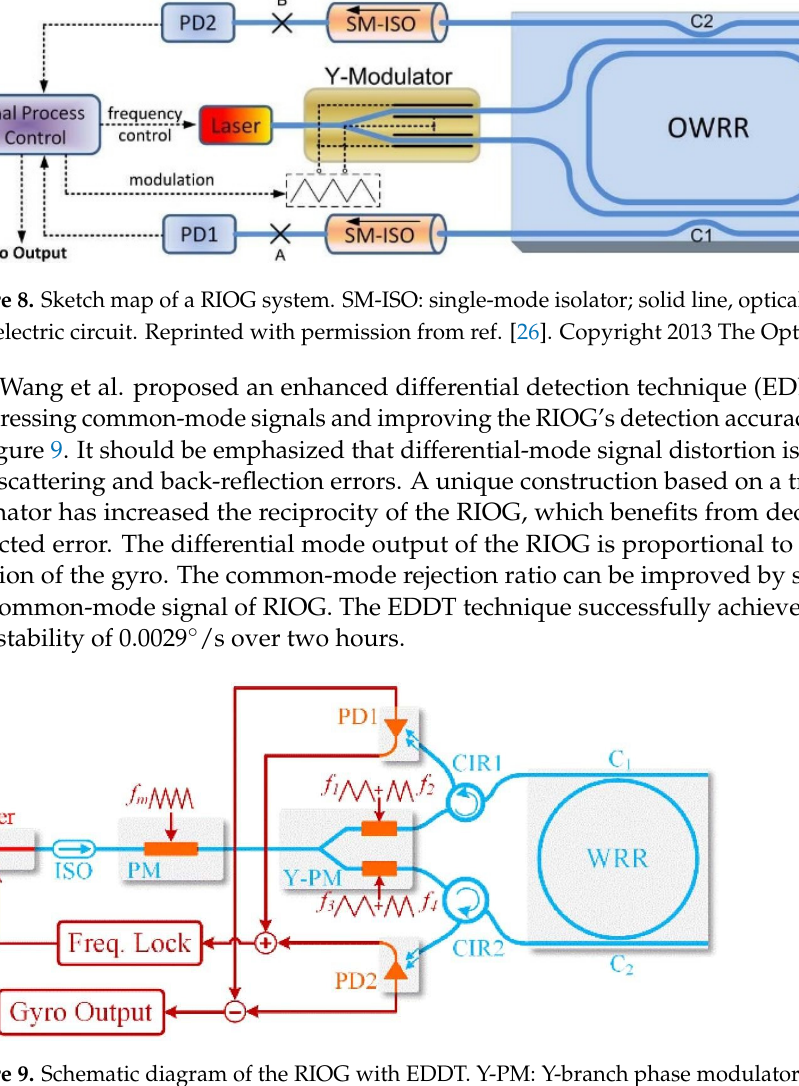
Figure 7. Schematic illustration of the RIOG with two facet-reflection dots. OWRR: optical wave- guide ring resonator.